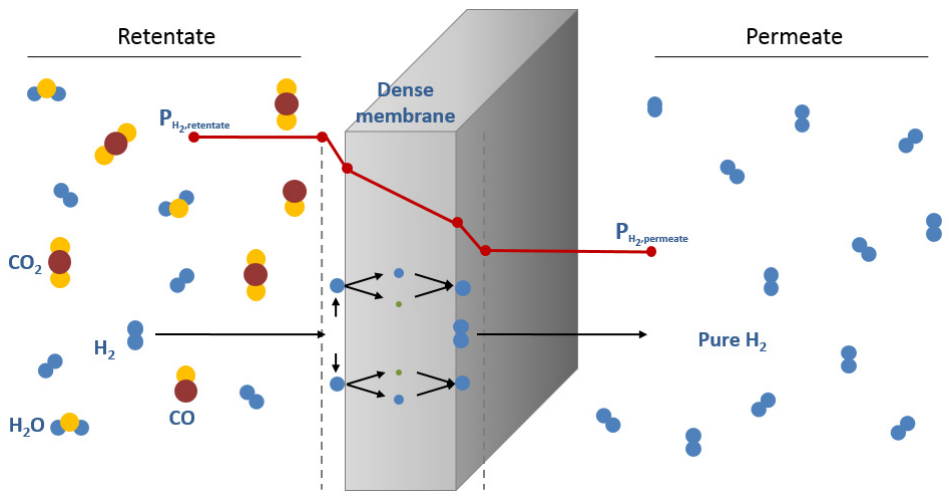
Figure 1. Solution-diffusion mechanism for hydrogen permeation through the metal lattice of a dense membrane.